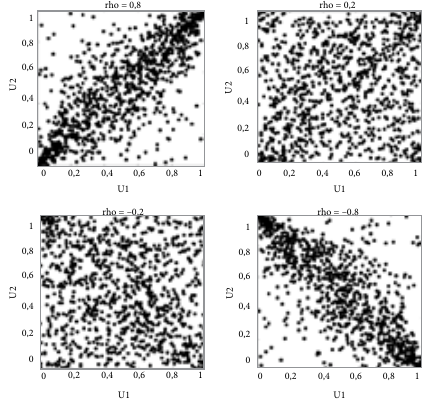
Fig 4. Student’s t-dependency structures with different correlation coefficients and ν =